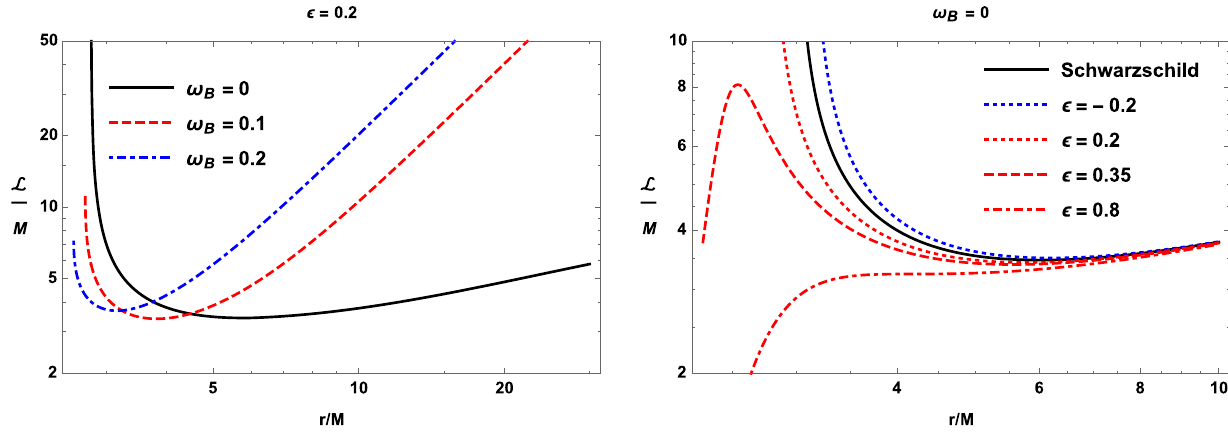
Fig. 2 Radialdependenceoftheangularmomentumofatestparticleforthedifferentvaluesofthemagneticinteraction(leftpanel)anddeformation (right